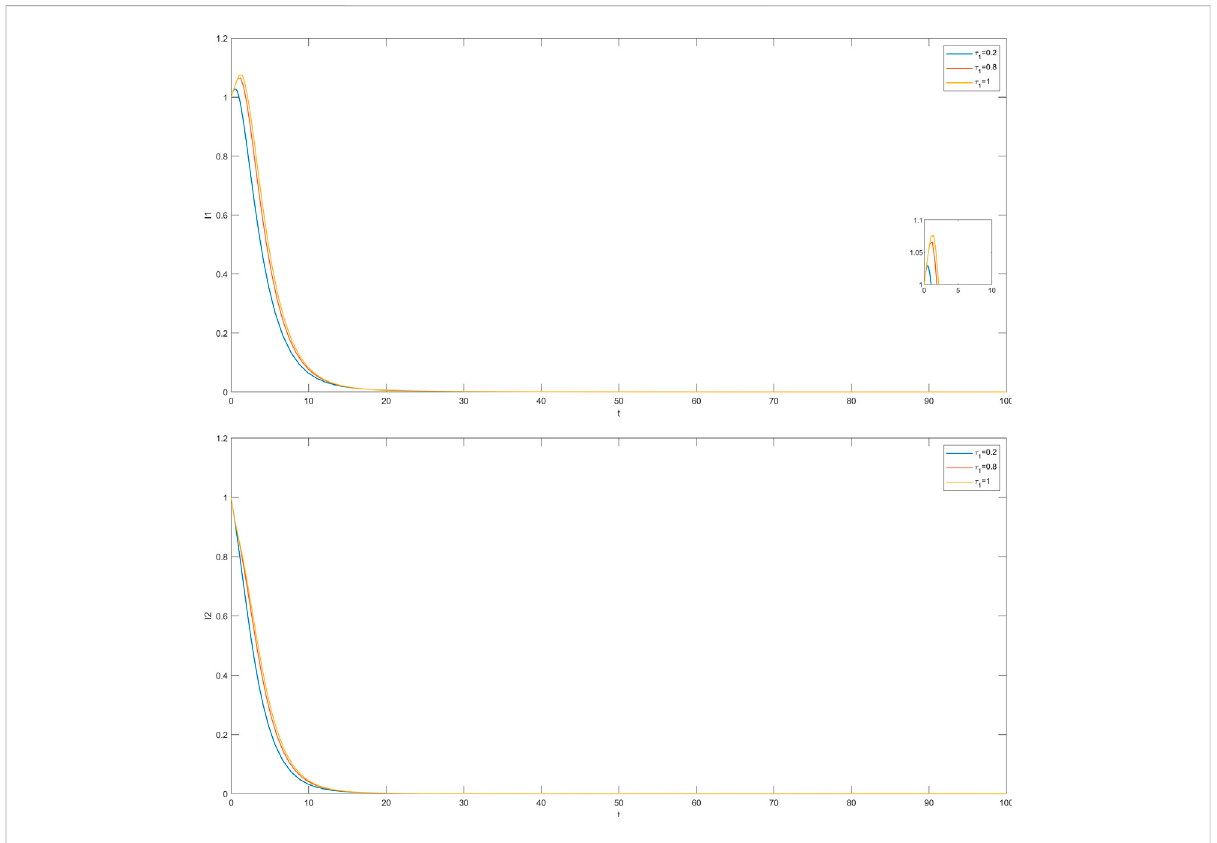
FIGURE 4 Trends of I 1 and I 2 with different time delays when R 0 <